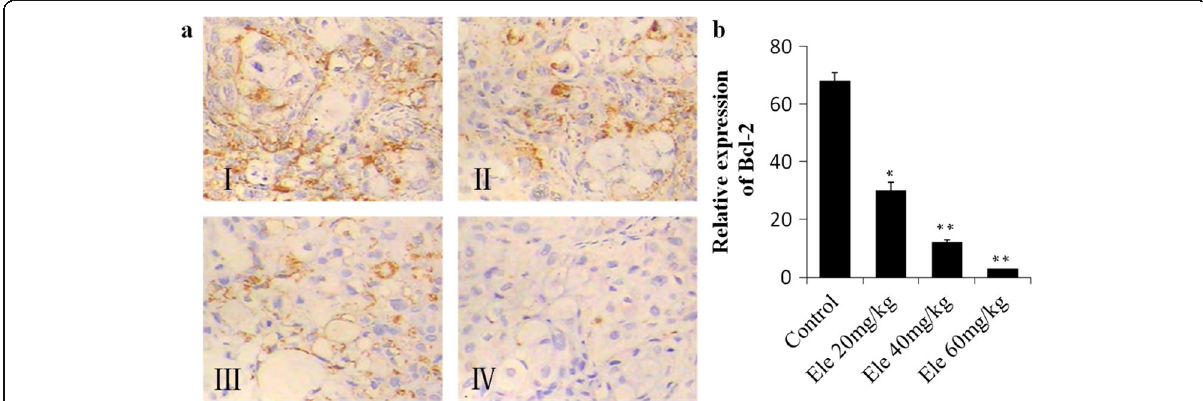
Fig. 5 a Representative photographs of Bcl-2 immunological histological chemistry examination (200 ×). I: Control group, II: Elemene 20 mg/kg group, III: Elemene 40 mg/kg group, IV: Elemene 60 mg/kg group. b Quantification of P53 stained cells. * P < 0.05, ** P < 0.01 vs control